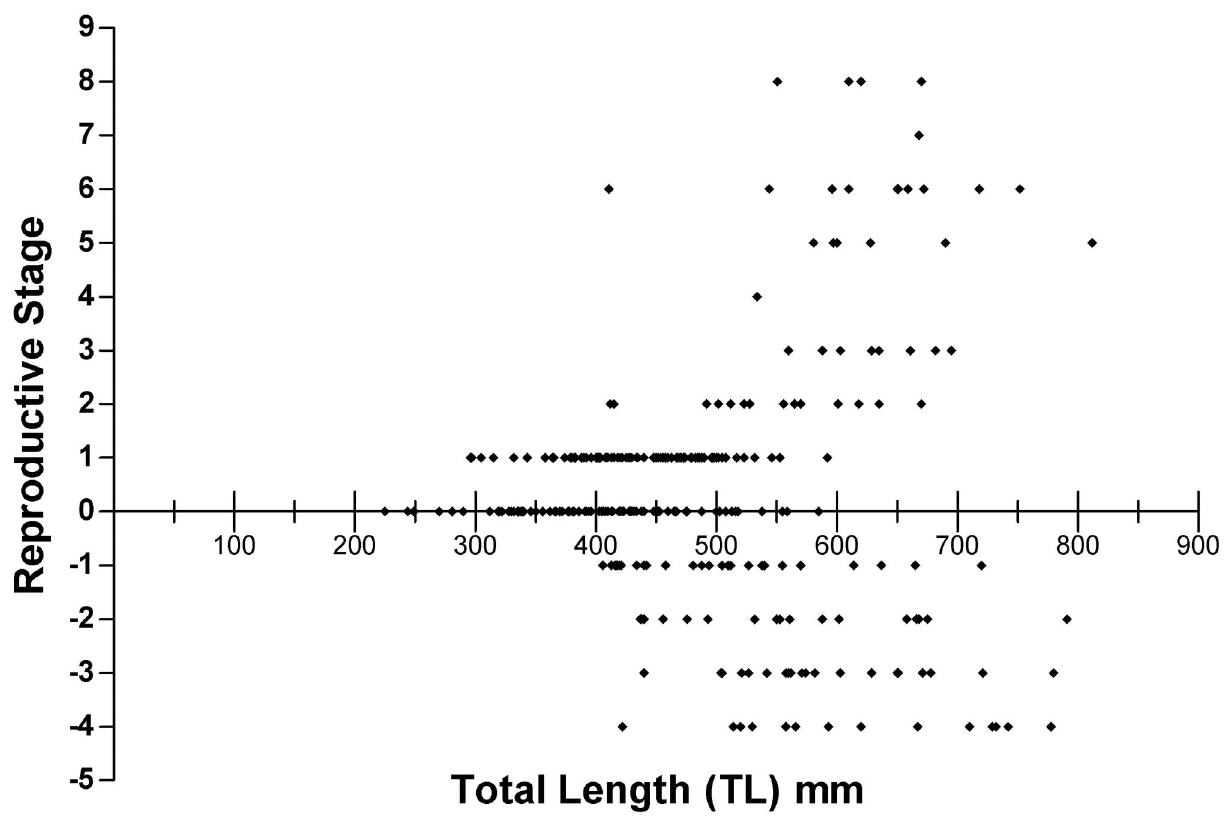
Figure 11. A scatterplot of reproductive stage vs total length. Note that all animals above 585 mm TL were readily identifiable as either male or